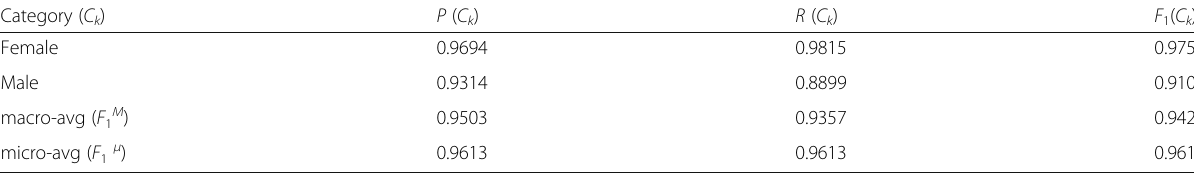
Table 12 Performance measure with identical hierarchy using cross validation =